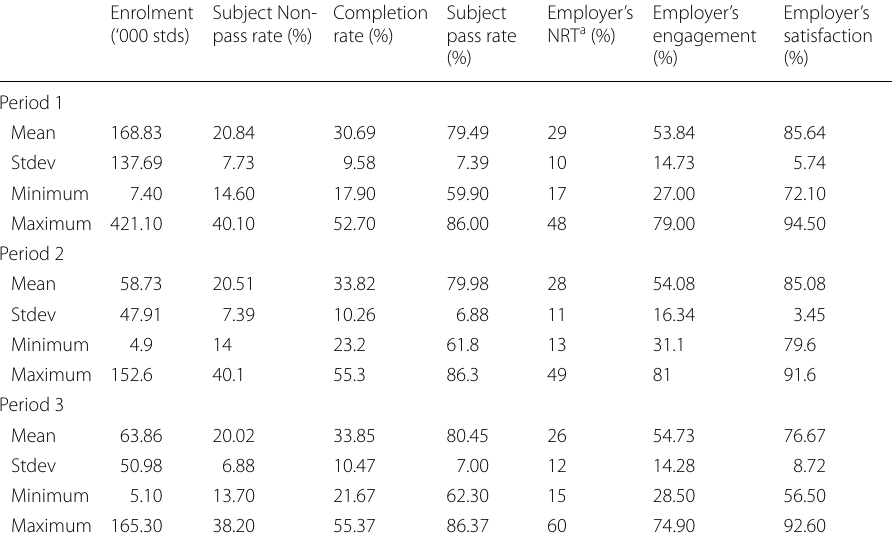
a NRT denotes employers using nationally recognised